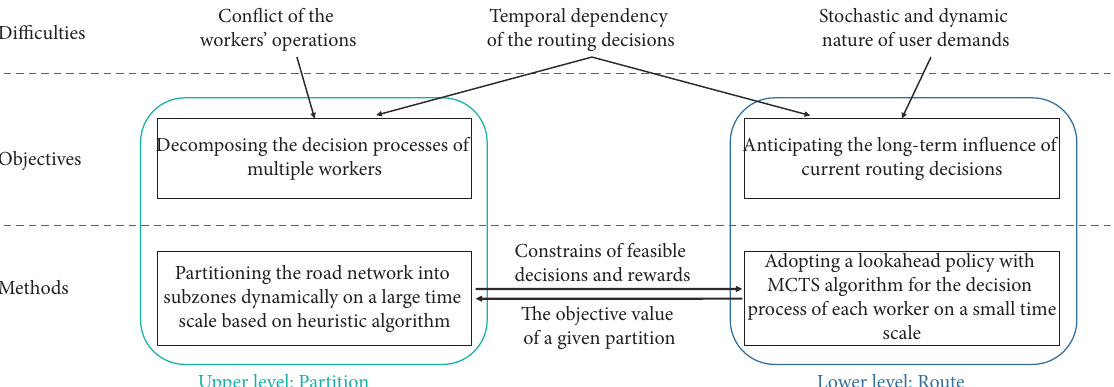
Figure 2: The “Partition-First, Route-Second” bi-level solution